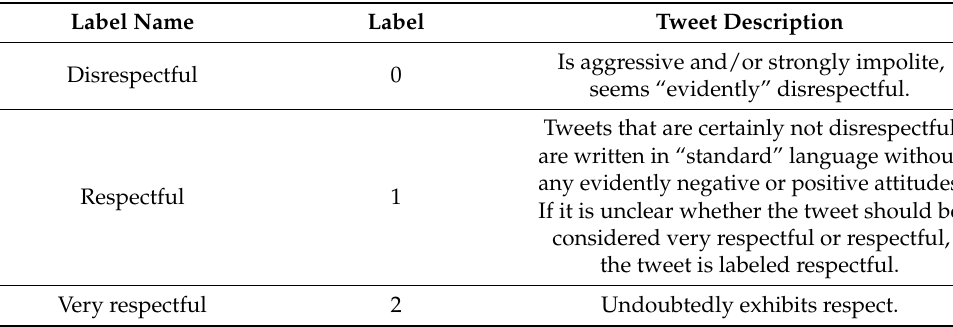
Table 1. Annotation scheme adopted in the